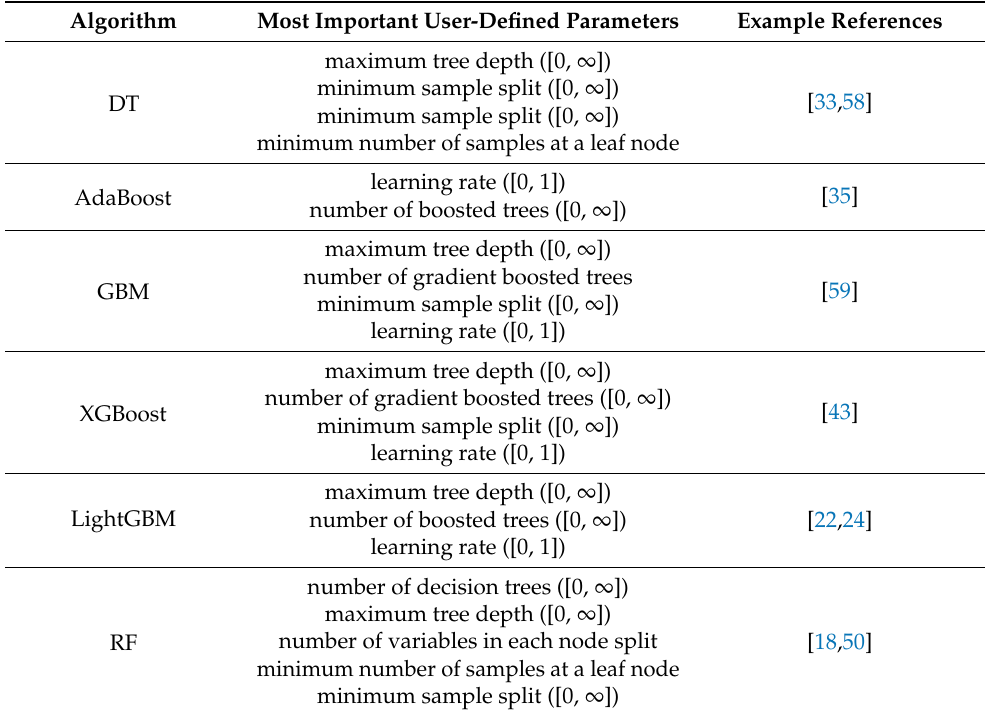
Table 11. Parameter Configuration of